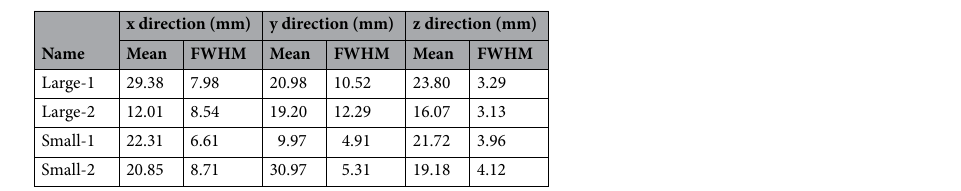
Table 1. The resulting mean and FWHM values of the reconstructed balls in the three-dimensional phantom along the x-, y-, and z-axes.